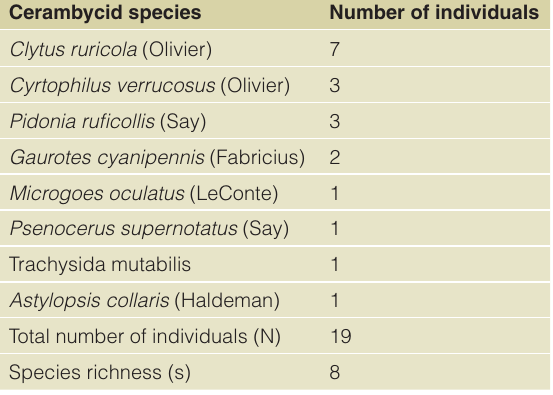
Table 2. Cerambycid (Coleoptera: Cerambycidae) Species Captured in Secor Woods, 2008 (Northern Lucas County, OH). Total number of individuals of each species caught during the entire trapping period (early June to early October). Traps were positioned in the approximate center of each forest and all checked each week.